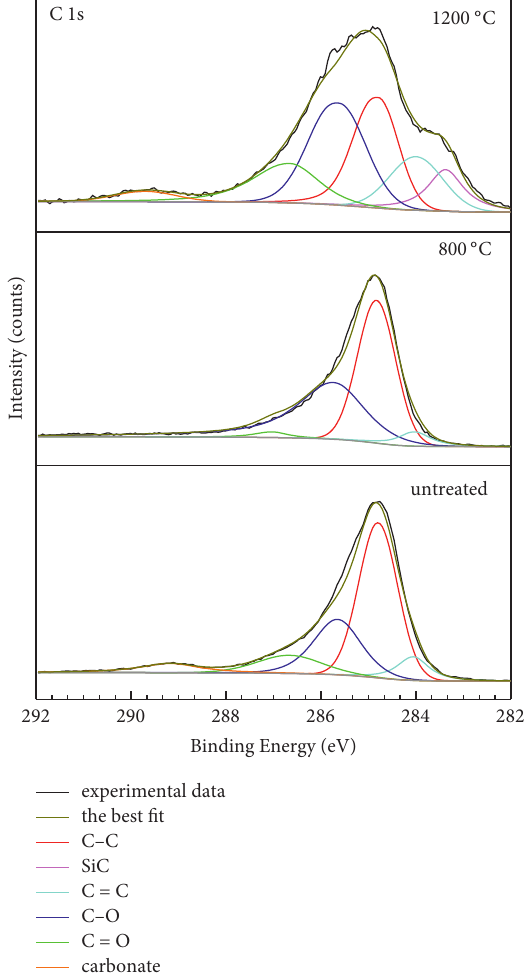
Figure 7: The spectra deconvolution of C 1s at different